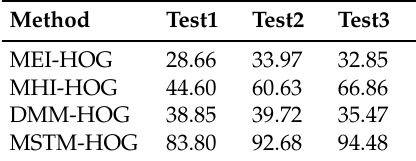
Table 5. The recognition rates (%) of different methods on